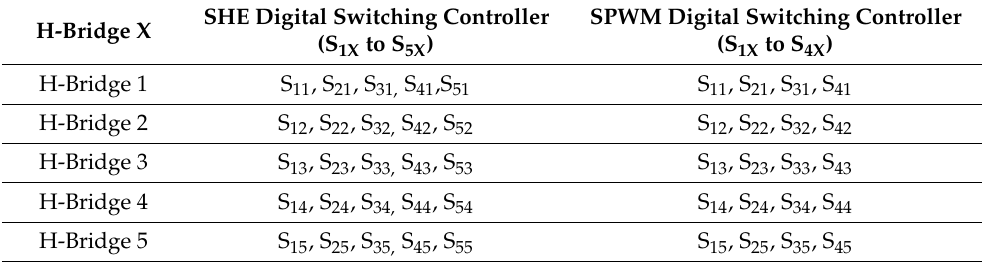
Table 2. IGBT switch arrangement for each H-bridge circuit for 21-Level SHE and SPWM multi- level